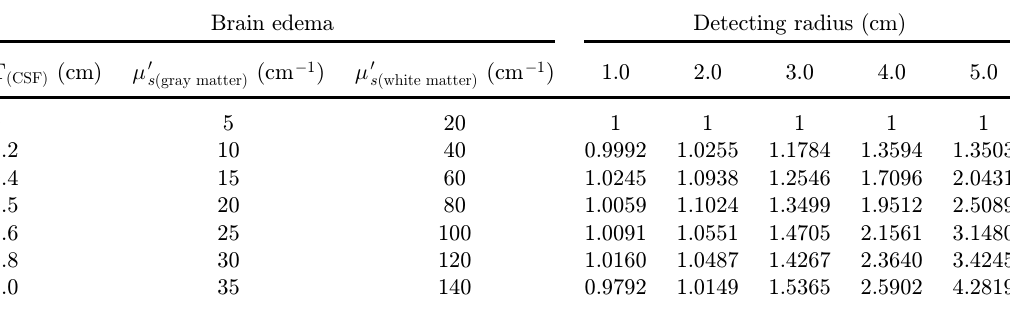
Table 5. The normalized light intensity in Model 4 0